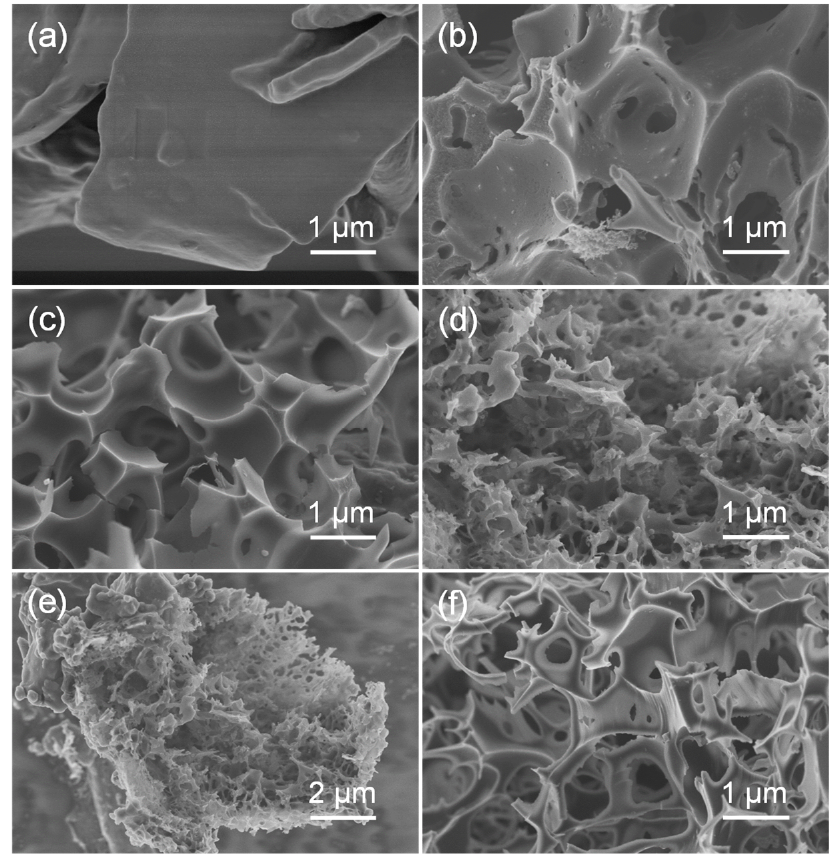
Figure 1. SEM images of NC ( a ), AC ( b ), BC-12 ( c ), BC-24 ( d , e ), BC-48 ( f ).